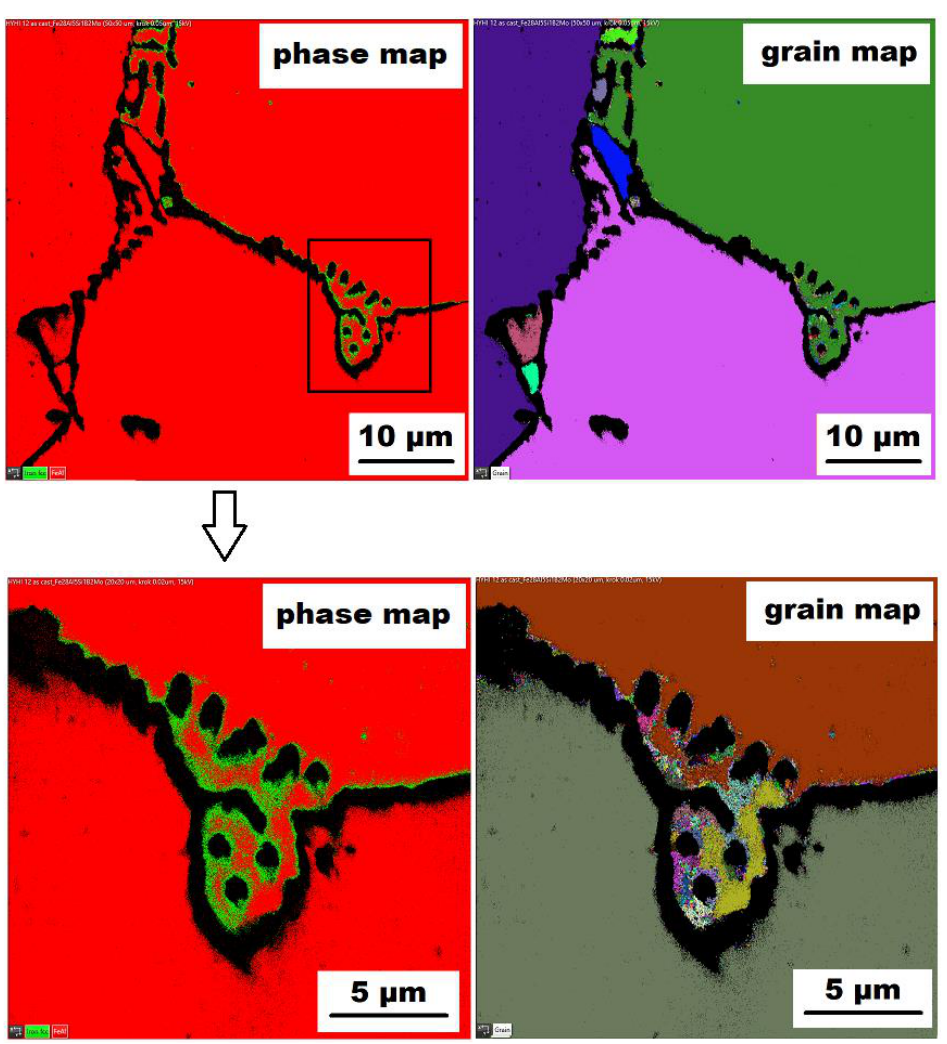
Figure 6. The EBSD phase and grain maps showing the gamma-iron presence in Fe – 28Al – 5Si – 2Mo – 1B as-cast alloy (green areas in phase maps), black areas — borides.